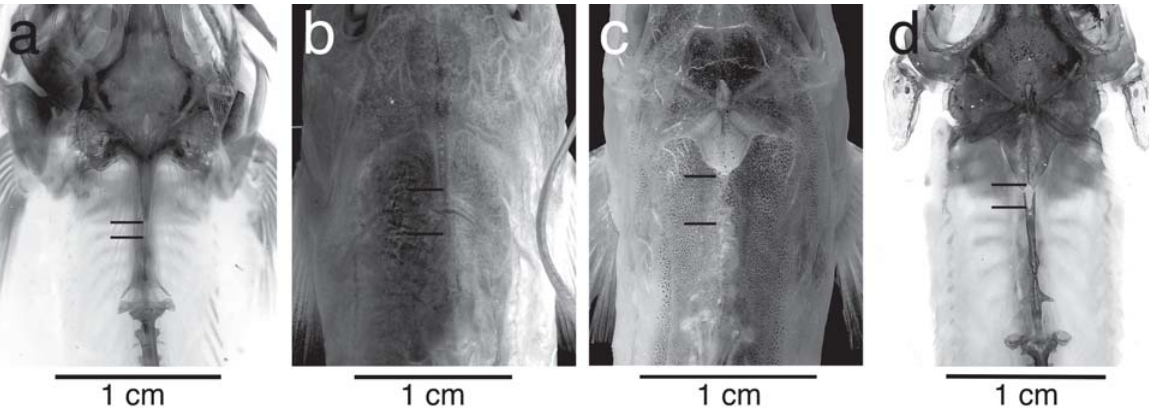
Fig. 3. Details of supraoccipital processes of a , Megalonema cf. platycephalum ANSP 178450, b , M. xanthum CAS 63674, c , M. amaxanthum , holotype, CBF 11896 (ex FMNH 106769), and d , M. orixanthum ANSP 148180, paratype. Paired lines on each image show the gap between the tip of supraoccipital process and supraneural anteromedial point in or just below skin.